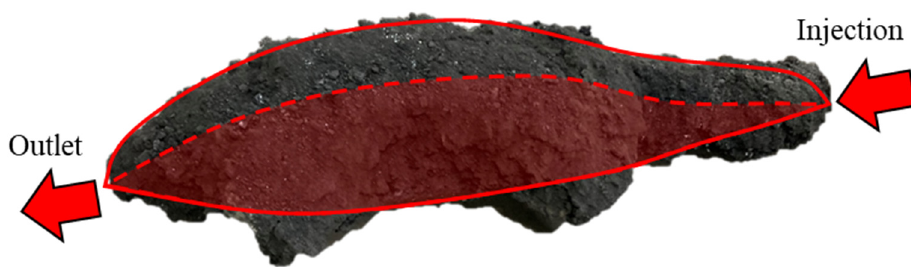
Figure 14. Cavity shape generated by continuously moving gas injection point (the second cavity).